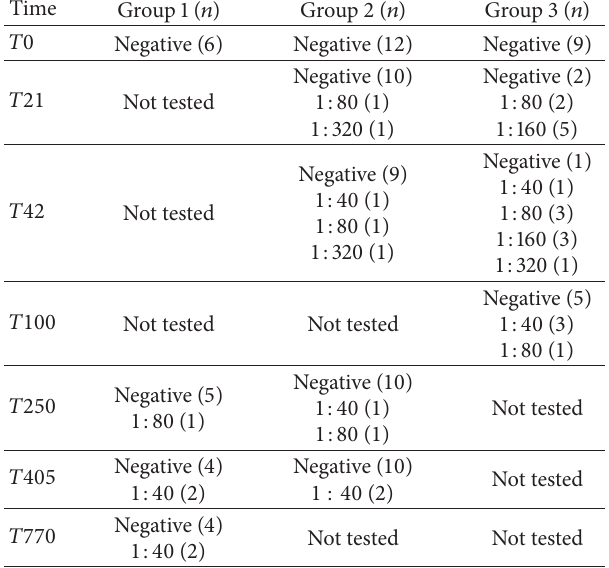
Table 4: IFAT L. infantum for the three groups of dogs.